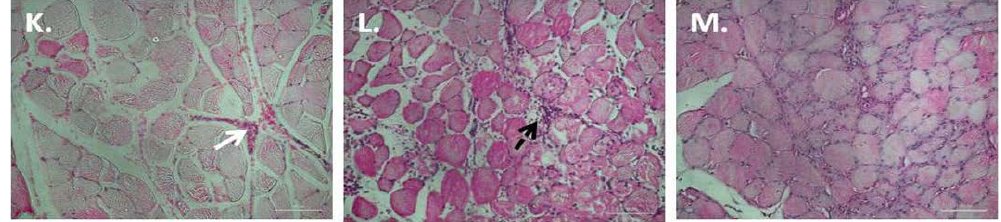
Figure 1. Ultrastructural changes over time after experimental contusion injury, stained by H & E. Figure ( A ) represent uninjured samples; Figures ( B – D ) represent samples taken from PLA animals at 3 h ( B ), 1 day ( C ) and 7 days ( D ) post-injury; Figures ( E – G ), ( H – J ) and ( K – M ) represent similar time points in the PG-CHR, PG-AI and NSAID groups respectively. Scale bar represents 100 μm; Figures ( B ), ( E ), ( H ) and ( K ) represent muscle fiber destruction and vascular disruption; Immune cells infiltration into the injured area is visible from 1 day post-injury (Figures ( C ), ( F ), ( I ) and ( L )). Solid white arrows indicate red blood cells, solid black arrows points to newly regenerated muscle fibers and dashed arrows indicate immune